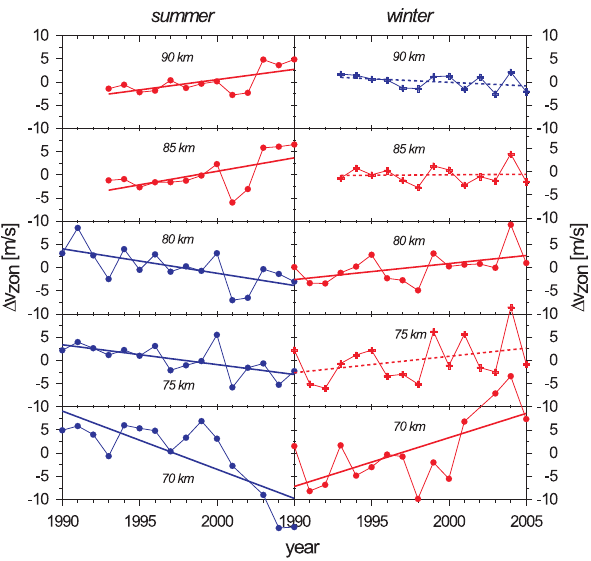
Fig. 17. Trend of the mesospheric meridional wind at Juliusruh after elimination of the solar activity induced parts for summer and win- ter conditions at different heights. Positive trends are red, negative trends blue. Significance levels are characterized by full lines and dots ( χ ≥ 95%), nonsignificant levels by dashed lines and crosses ( χ<